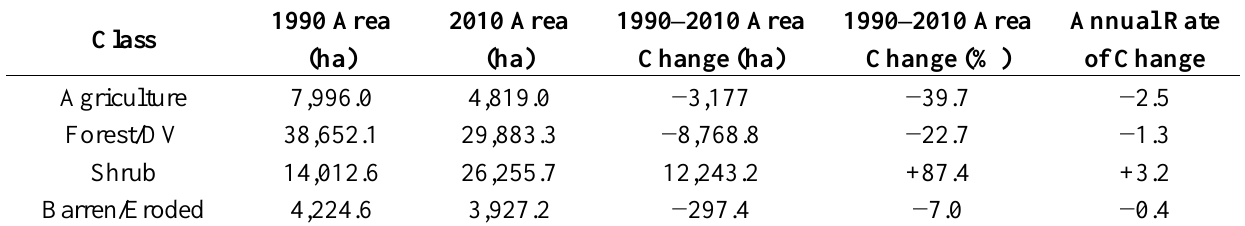
Table 2. Land cover class areas and rates of change for respective time periods.